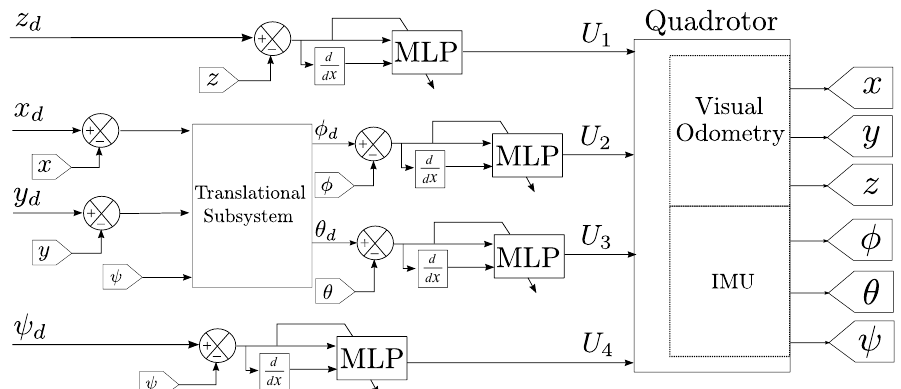
Figure 6. Control of quadrotor with MLP. There is one MLP module for each Degree of Freedom to control.